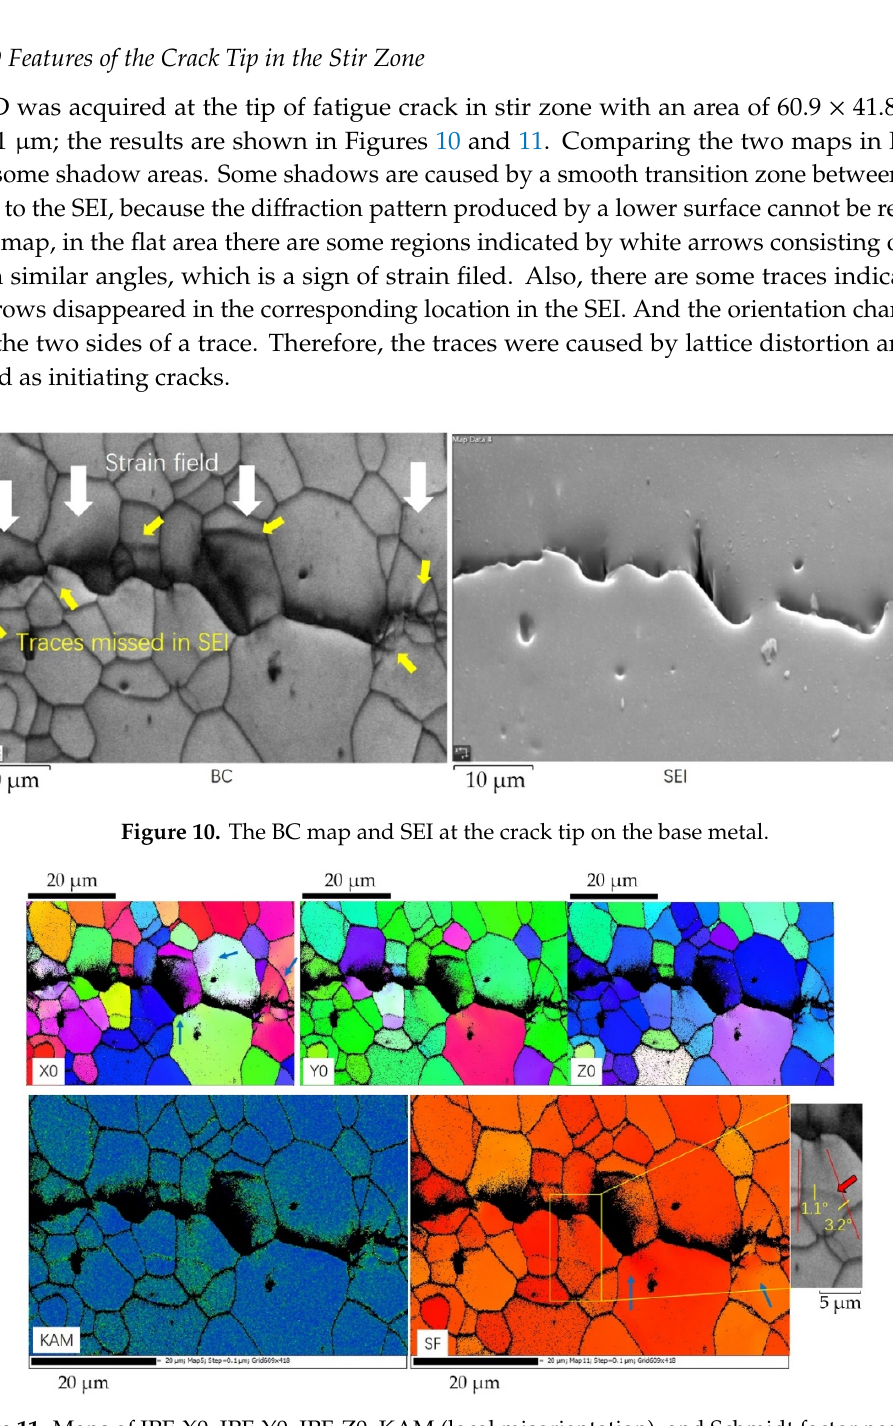
Figure 11. Maps of IPF-X0, IPF-Y0, IPF-Z0, KAM (local misorientation), and Schmidt factor near the crack in stir zone.